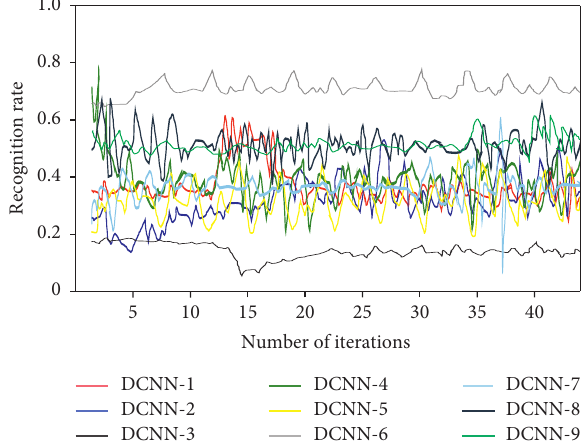
Figure 6: The change of recognition rate of convolution neural network model with different structure depth with iteration